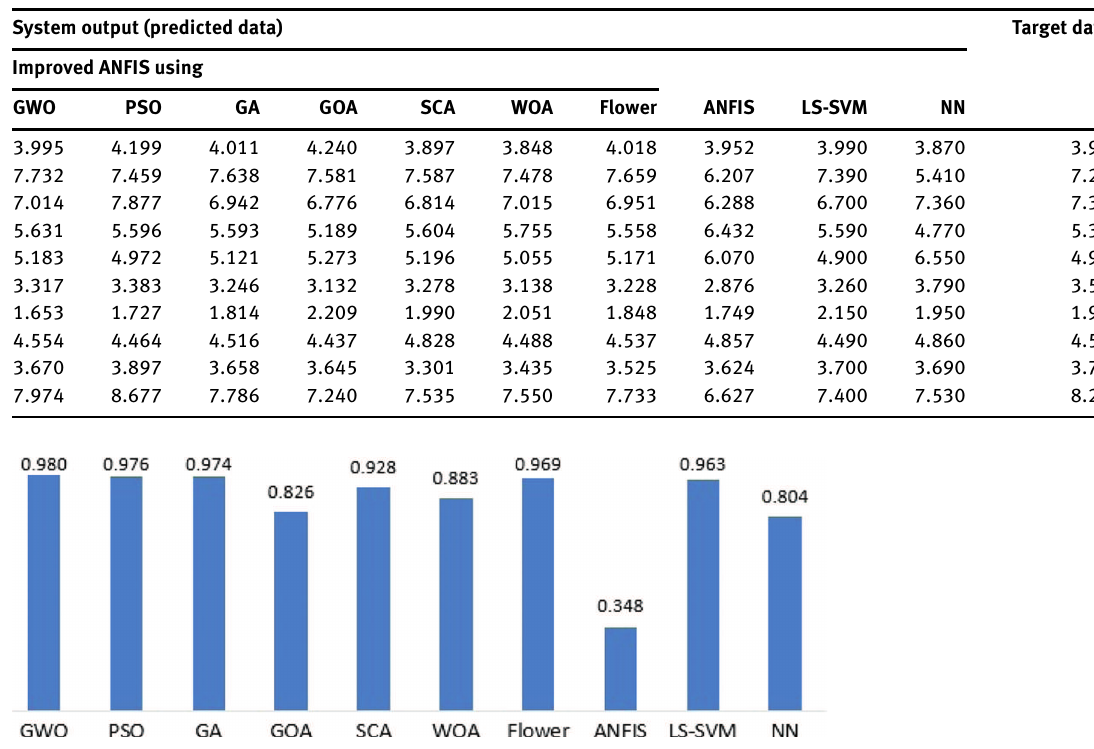
Table 6: Comparison between the Sample Case of Predicted Data and Target Data.